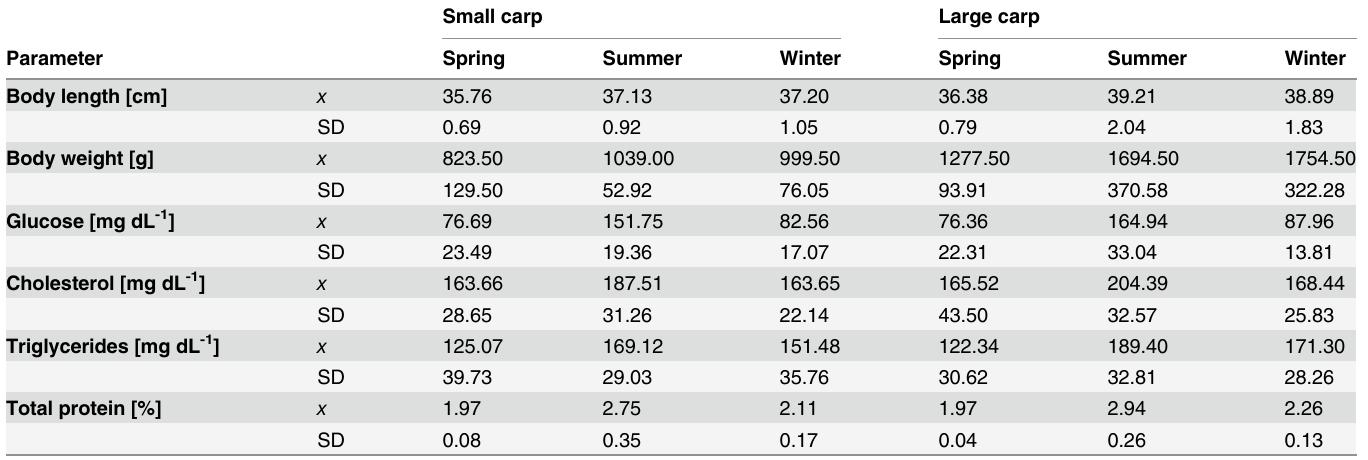
Table 3. Seasonal changes in fish size, glucose, cholesterol, triglycerides, and total protein concentrations.